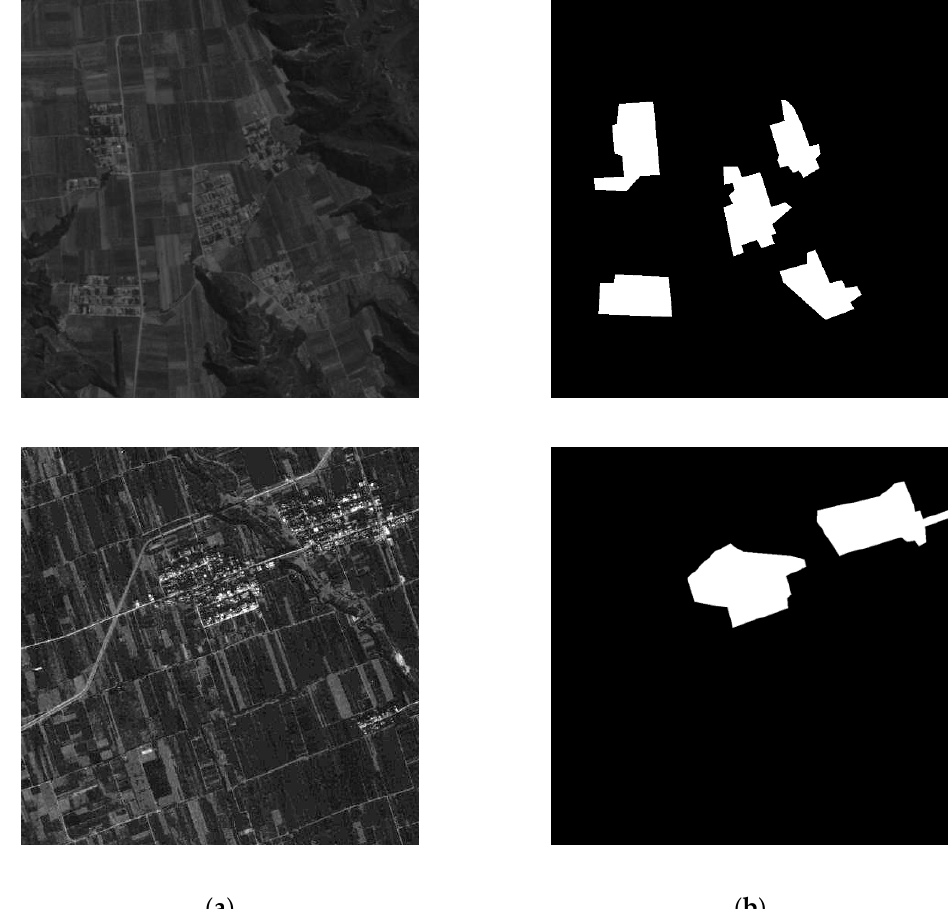
Figure 2. Label visualization for a remote sensing image: ( a ) Original image and ( b ) label image. Table 2. The proportion of residential area in our dataset.